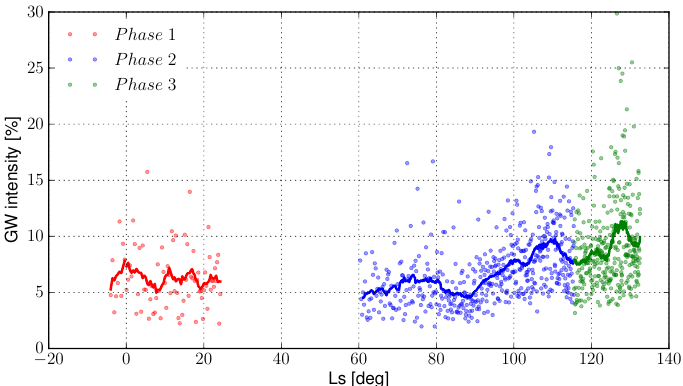
Figure 8. Amplitude of relative density fluctuations as a function of season (solar longitude, L s ). The running mean has been calculated by averaging over passes with pericenters within the interval of the given L s . No more than the 40 passes closest in time were considered for each point. More information on the altitude dependence of density fluctuation amplitudes is given in Figure